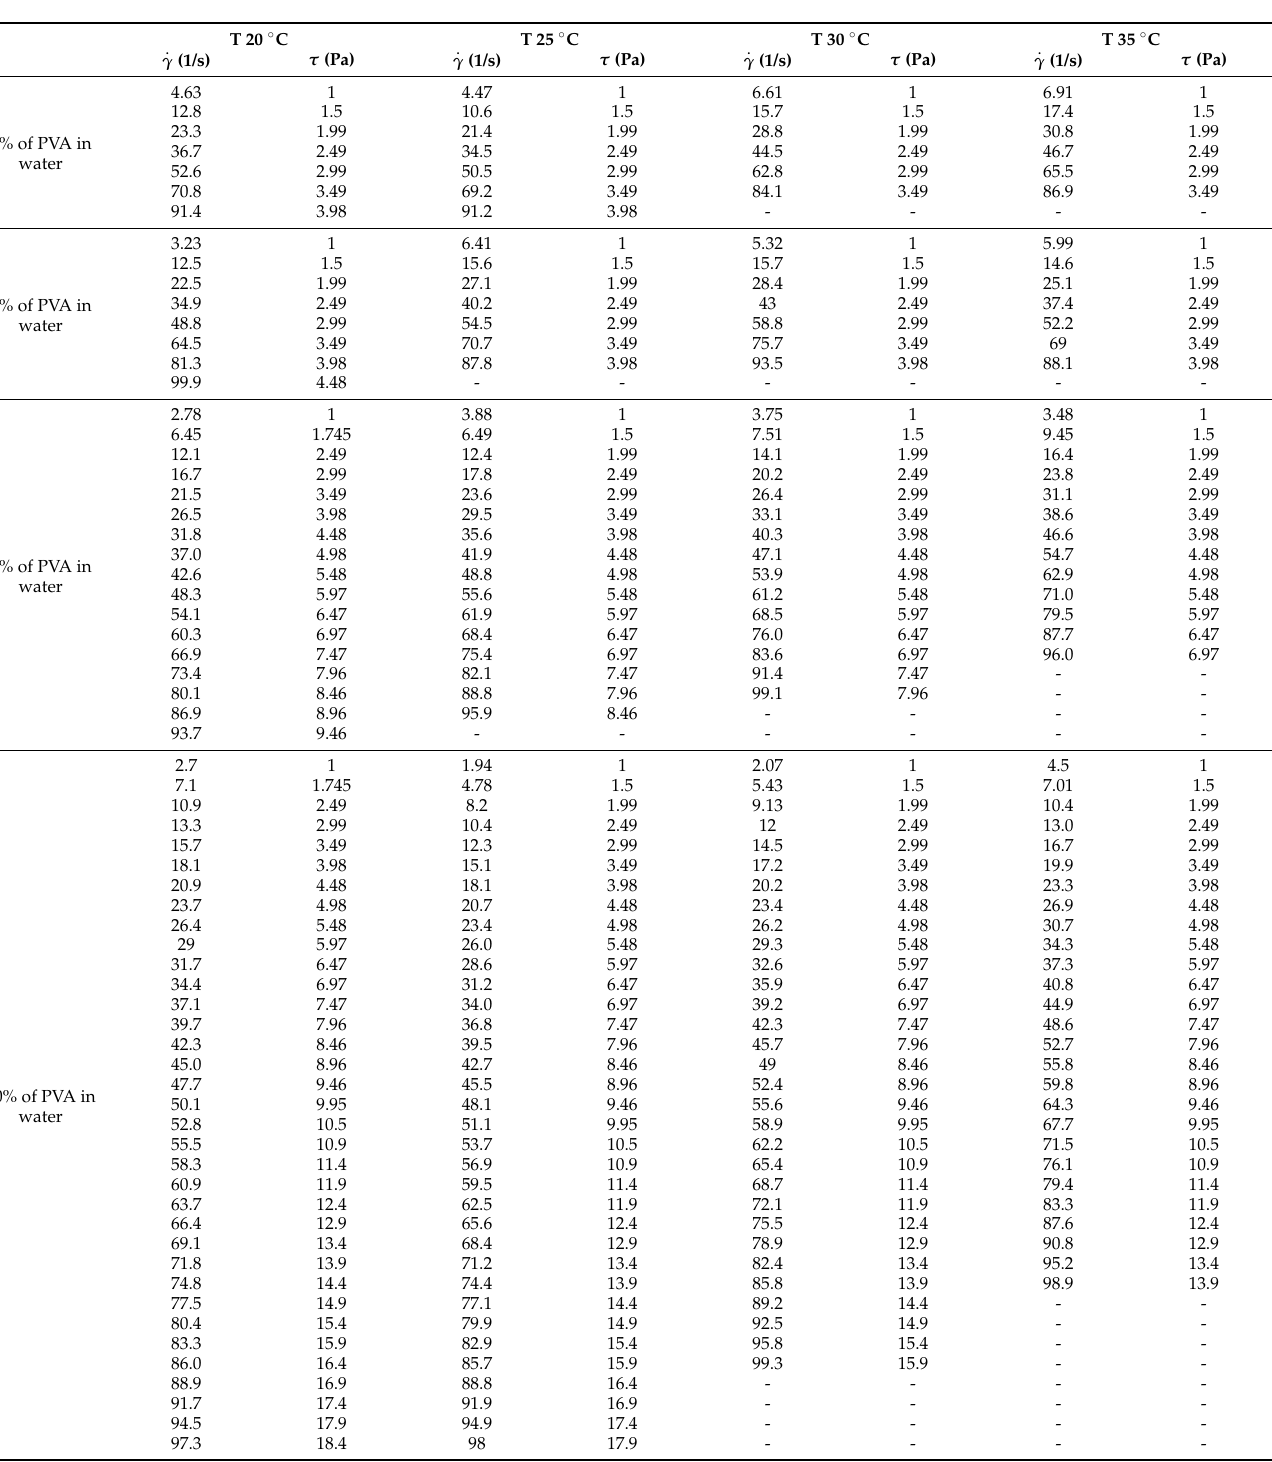
Table 2. Rheology Data for Polyvinyl Alcohol 4, 6, 8 and